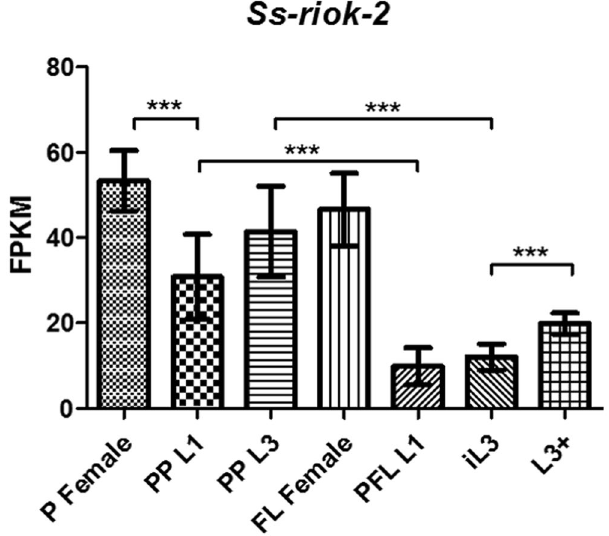
Figure 6. Transcriptional profile of Ss-riok-2 in seven Strongyloides stercoralis life stages. Transcript abundances were compared in biological triplicate. Stages examined were: parasitic females (P Female), post-parasitic first- stage larvae (PP L1), post-parasitic third-stage larvae (PP L3), free-living females (FL Female), post-free-living first-stage larvae (PFL L1), infectious third-stage larvae (iL3), and in vivo activated third-stage larvae (L3 + ). Transcript abundances are expressed as fragments per kilobase of coding exon per million mapped reads (FPKM). Error bars represent 95% confidence